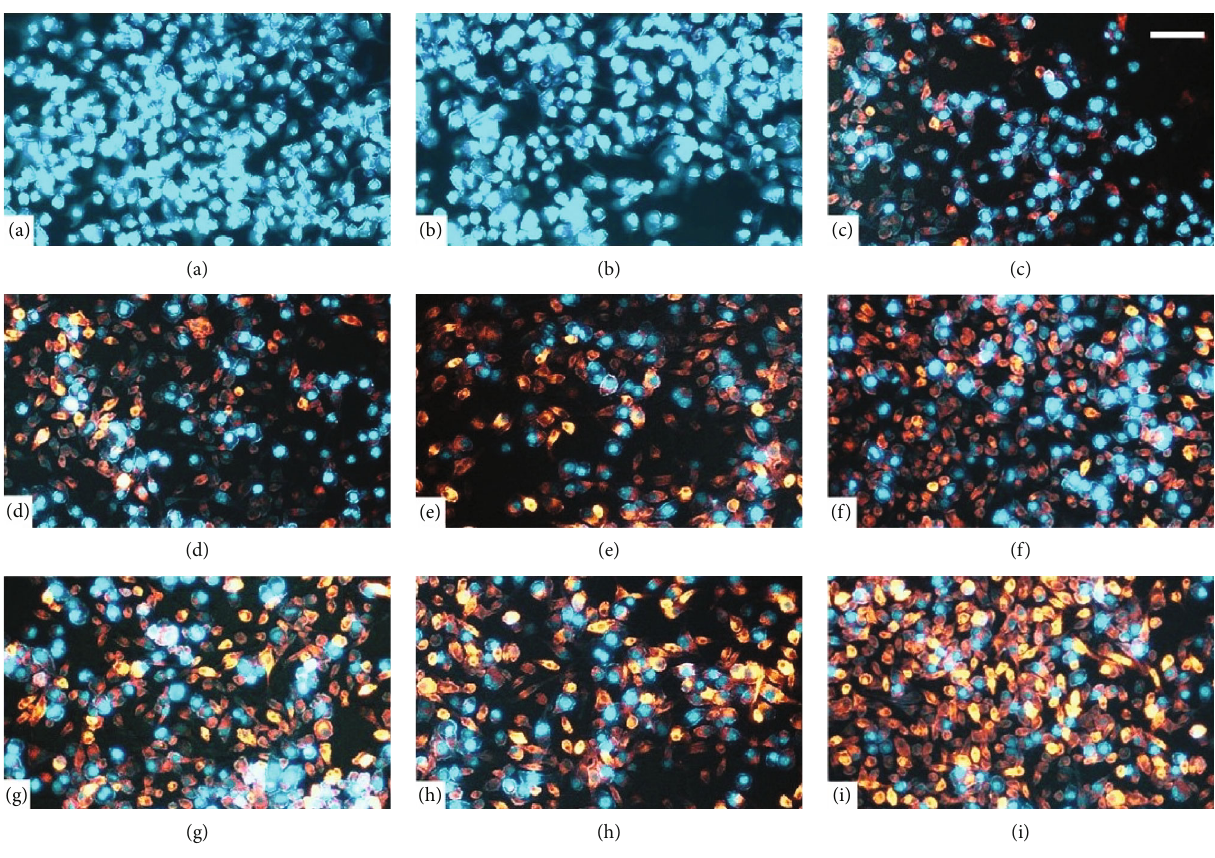
Figure 1: Representative fl uorescence microscopy of microglial cells stained with DAPI (blue, cell nuclei) and Lumogallion probe (orange) to track uptake of Al: (a) control; (b) lipopolysaccharide (LPS, 1 μ g/mL); (c) AlCl (1 μ M); (d) AlCl (5 μ M); (e) AlCl (10 μ M); (f) AlCl 3 3 3 3 (50 μ M); (g) AlCl (100 μ M); (h) AlCl (500 μ M); (i) AlCl (1000 μ M). Magnification = 200x . Scale bar = 20 μ m . n = 3 3 3 3